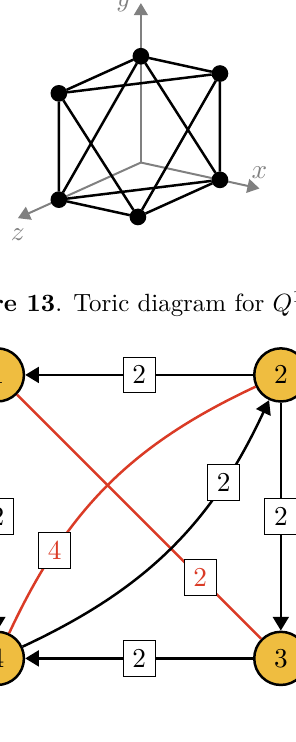
Figure 14 . Quiver diagram for phase A of Q 1 , 1 , 1